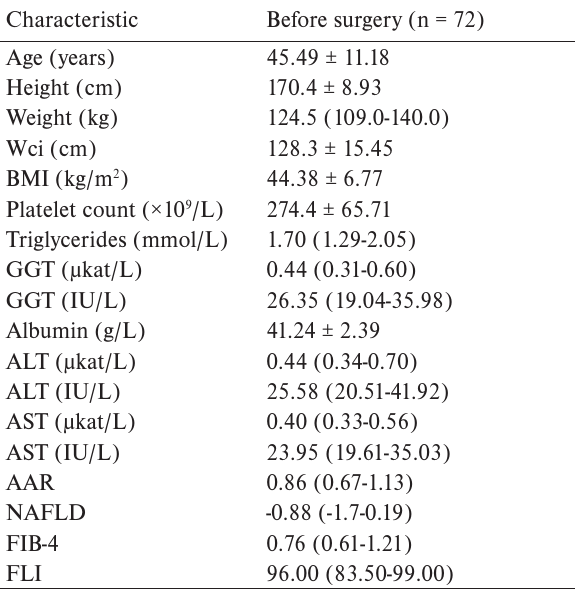
Table 1. Baseline characteristics of morbidly obese